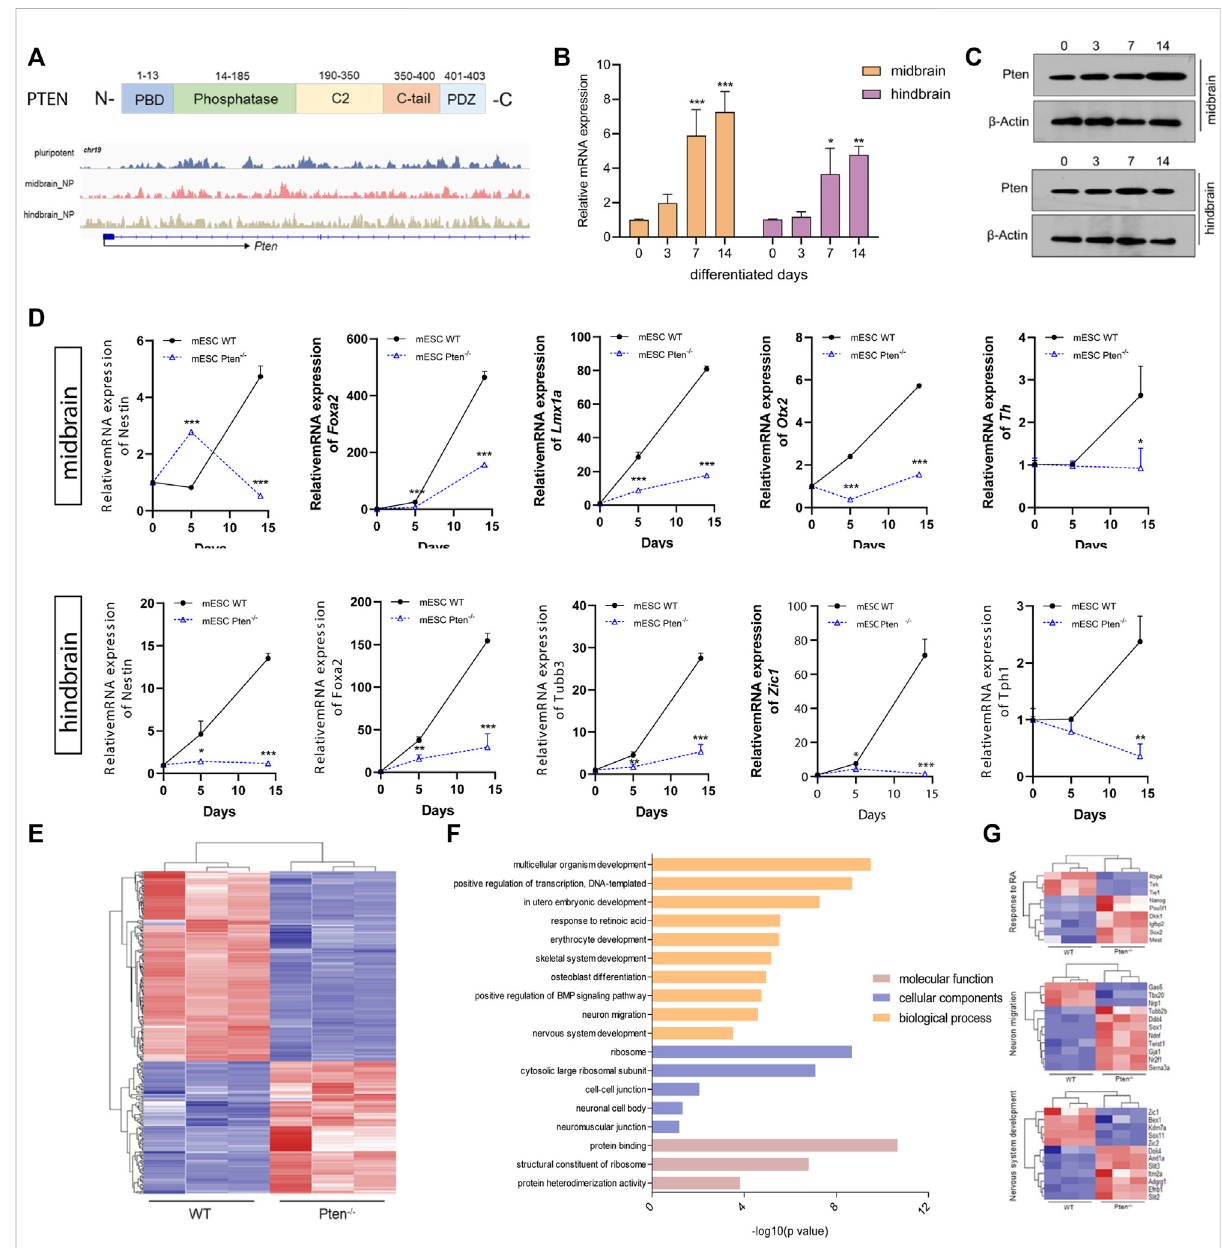
FIGURE 4 Lossof Pten disrupted neurogenesis towardsmidbrain and hindbrainspeci fi cation. (A) Genome browser visualization of5hmC patternsofPten in the midbrain and hindbrain progenitors derived from wild type (WT) and Pten − / − (KO) mESCs. The mRNA (B) and protein expression (C) of Pten in the differentiation of midbrain and hindbrain speci fi cation. (D) Transcriptional expression of midbrain and hindbrain markers in WT and KO ESCs. (E) Heatmap of pluripotency genes in WT and Pten − / − ESCs. (F) Gene ontology analysis for the DEGs identi fi ed pathways associated with the nervous system development. (G) Selected DEGs responsible for the neuronal development. All data are expressed as mean ± SD ( n = 3). * p < 0.05, ** p < 0.01, and *** p < 0.001; # p < 0.05, ## p < 0.01, and ### p <